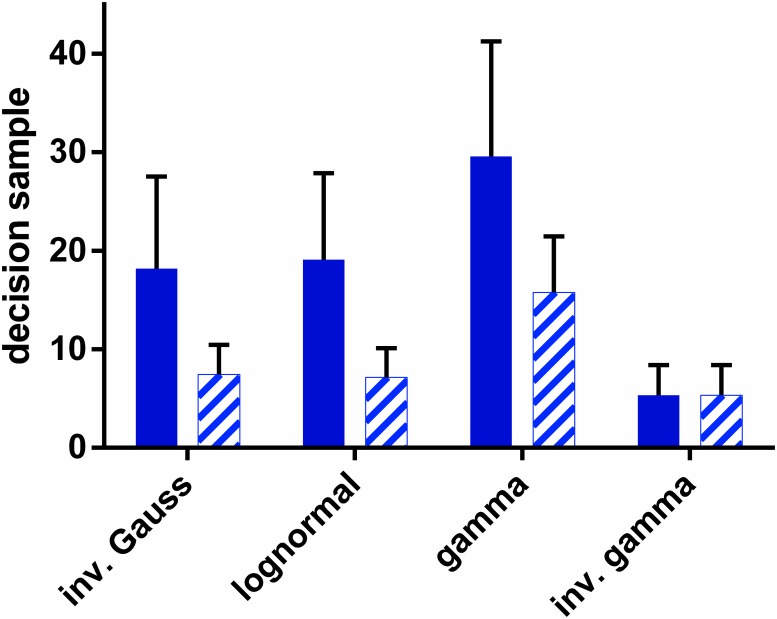
Decision sample for u-MSPRT when the distributions in
the data were not matched to those tested for.Each bar shows the mean decision sample, for N = 10 alternatives, averaged over 950 correct out of 1000 total trials. The parameter set was ΩIV. The pale, patterned bars are for the case when the data is always sampled from an inverse gamma distribution, but inserted into mechanisms which test using the distribution indicated on the x − axis (by definition, the bars have equal height for the inverse gamma). The solid bars are for the case when the tested-for distribution matches the true distribution of ISIs, as indicated on the x − axis. Error bars are at one standard deviation.